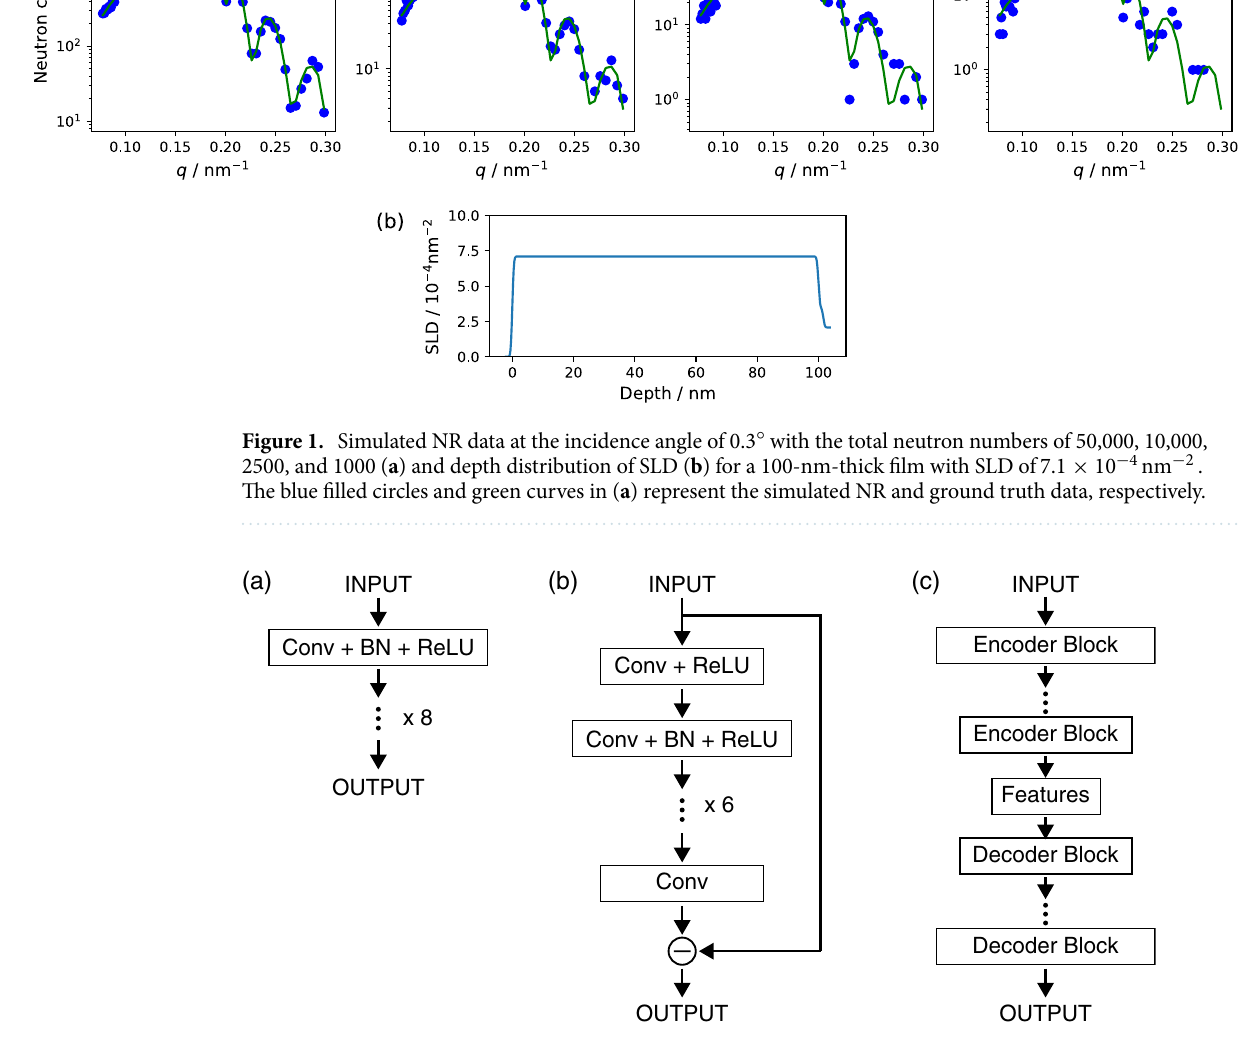
Figure 2. Network architectures of pCNN ( a ), DnCNN ( b ), and CAE ( c ). Conv : one-dimensional convolution, BN : batch normalization, ReLU : rectified linear